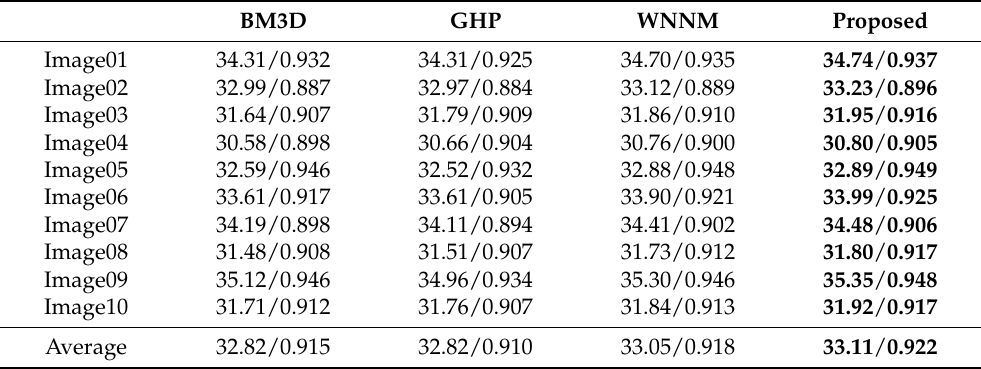
Table 1. The PSNR [dB] and SSIM results obtained after denoising on dataset I (with a noise standard deviation of 𝜎 = 10).